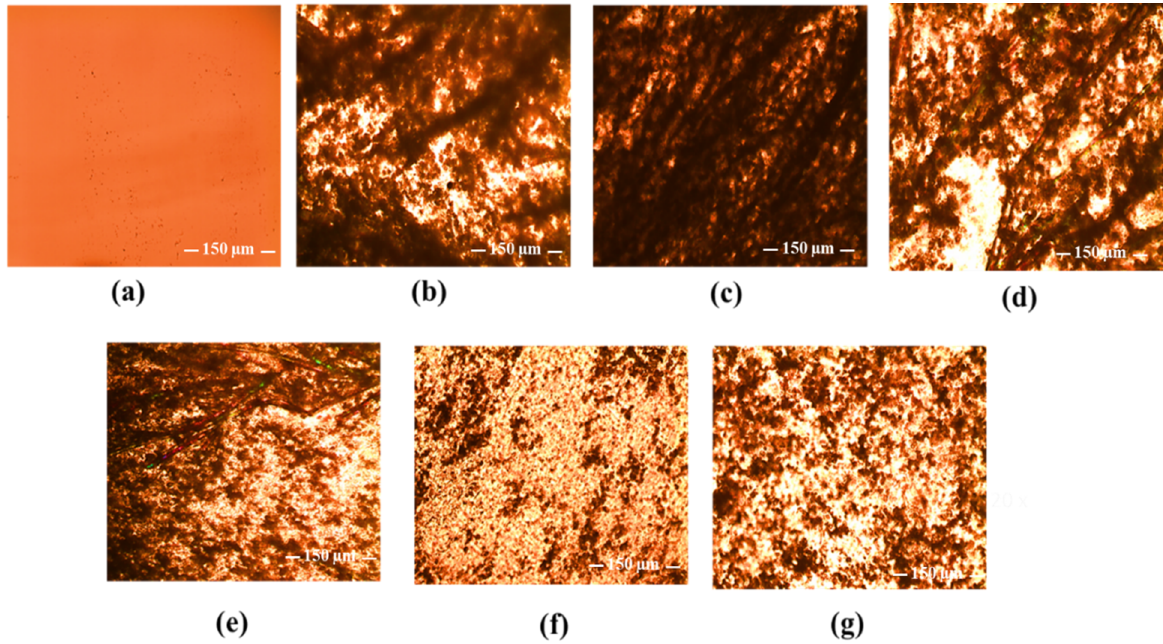
Figure 12. Polarized light microscope images of drug-free CHI/P3HPEI film ( a ) and CHI/P3HPEI films loaded with haloperidol (HP) at various% drug loading, 5.0% ( b ), 2.5% ( c ), 2.0% ( d ), 1.75% ( e ), 1.5% ( f ), and 1.25% ( g ) (20× magnification). Scale bars are 150 µm.